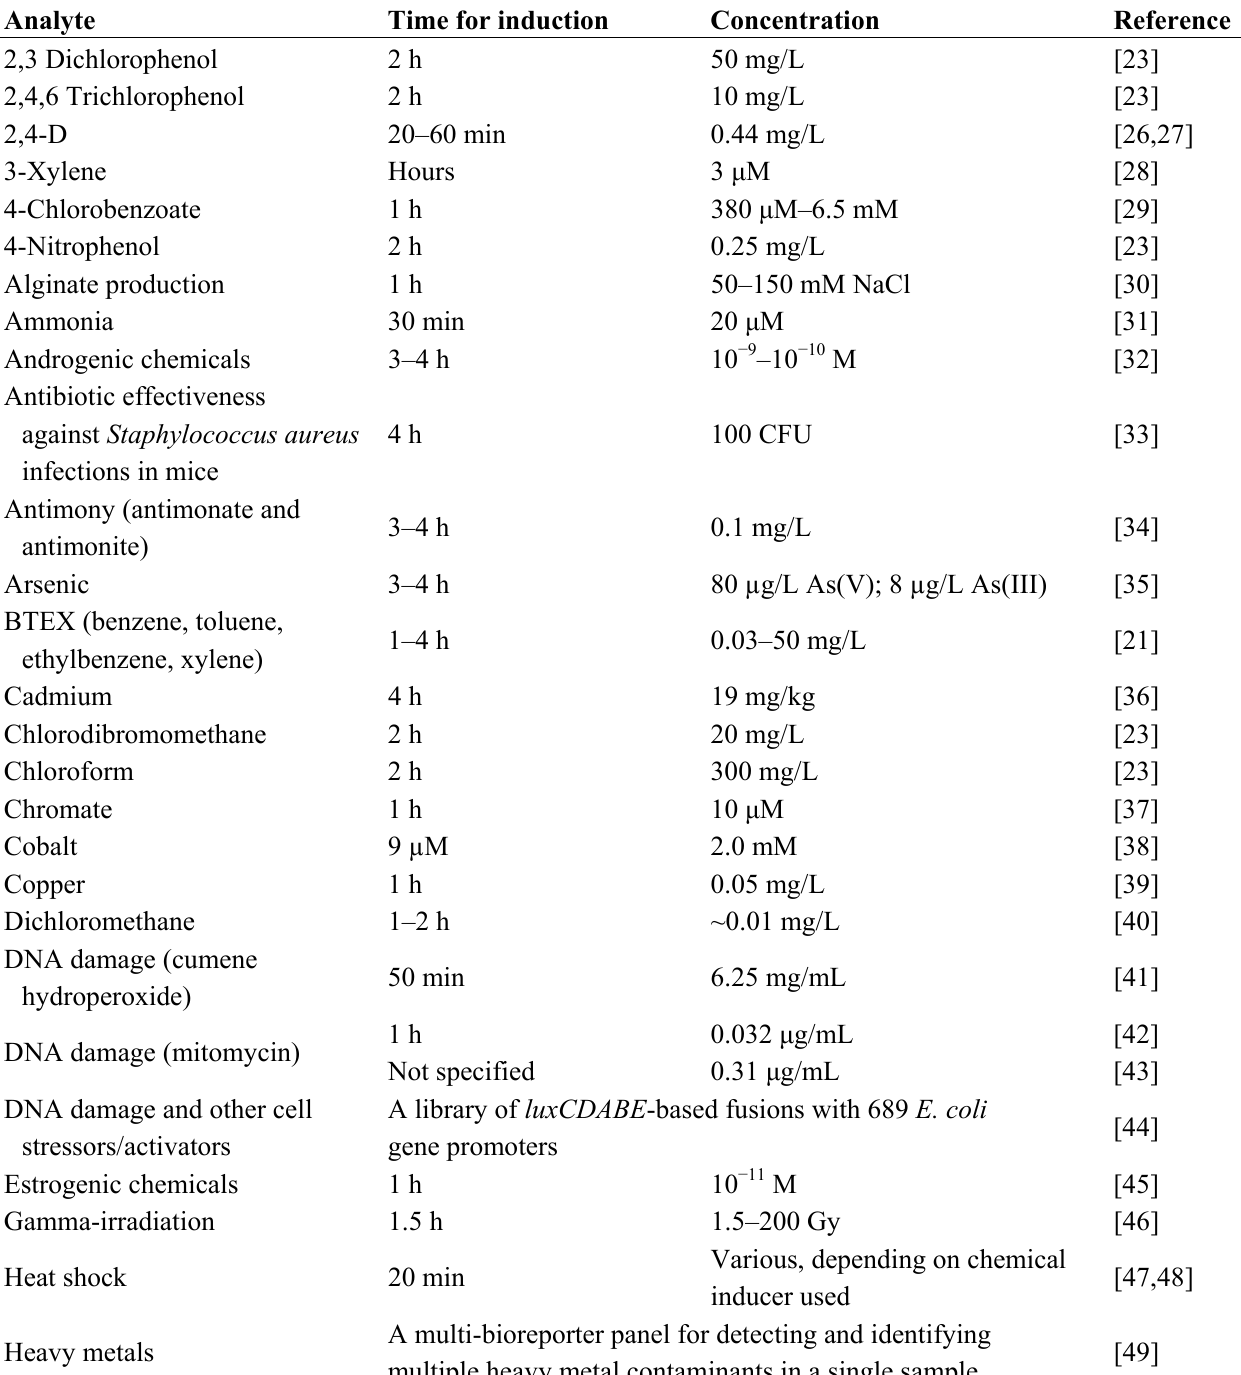
Table 1. A representative listing of luxCDABE -based